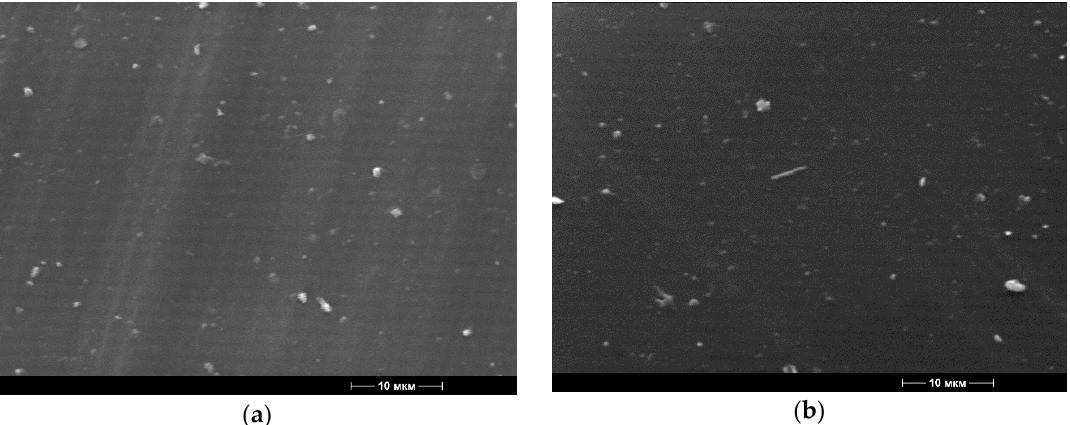
Figure 2. Microphotographs of the surface structure of the materials (5000× magnification) based on polyethylene with 2.0% content of birch bark extract, received with the use of ultrasonic treatment ( a ) and without the use of ultrasonic treatment ( b ).